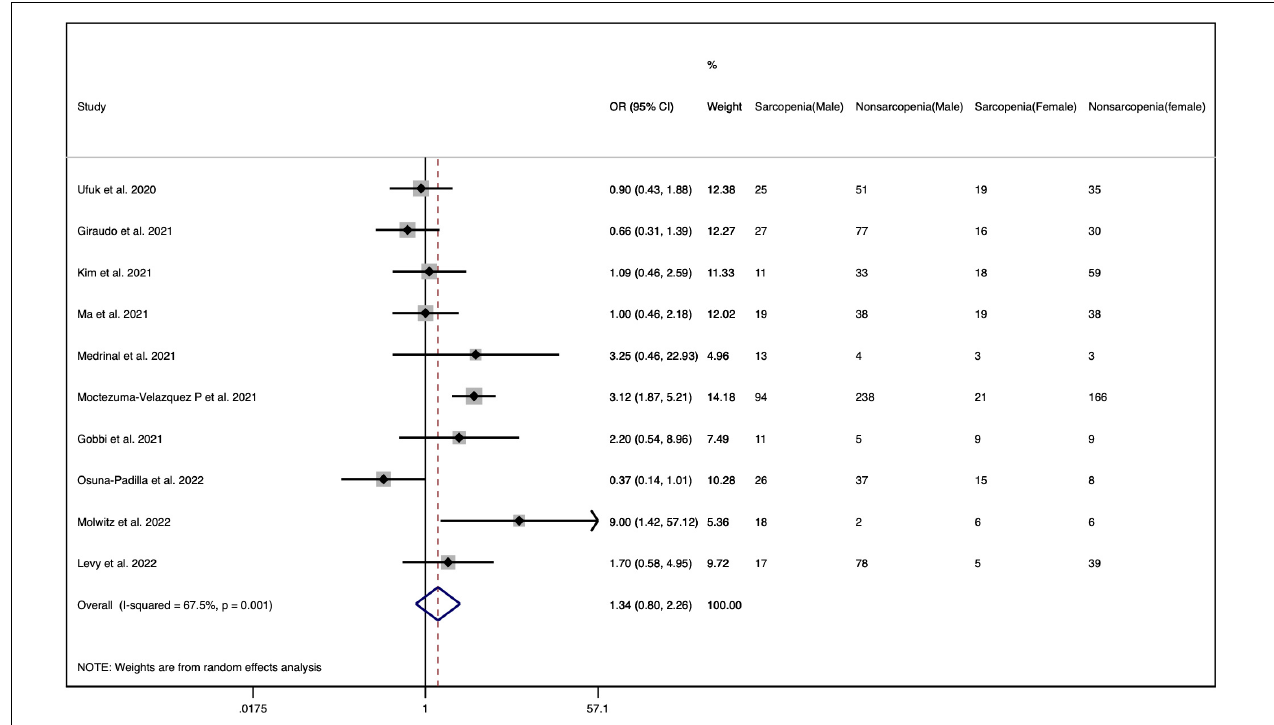
FIGURE 3 | The pooled odds ratios of the association between gender and COVID-19-related